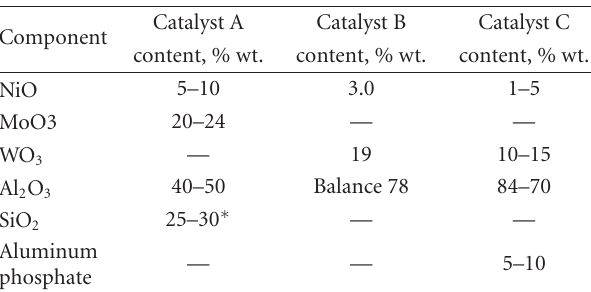
Table 3: Approximate composition of catalysts.